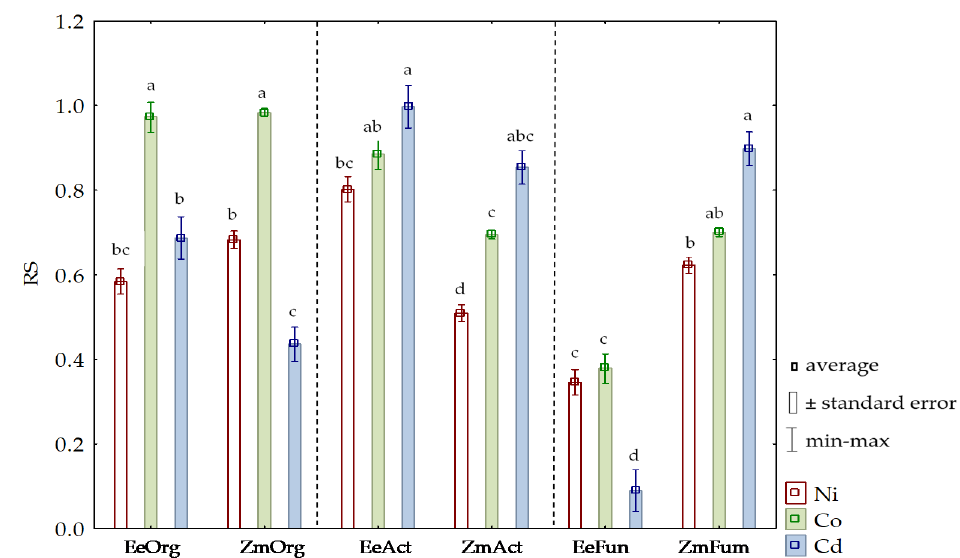
Figure 3. Resistance (RS) of microorganisms to heavy metals in the soil sown with Elymus elongatus L. and Zea mays L. Ee— Elymus elongatus L.; Zm— Zea mays L.; Org—organotrophic bacteria; Act— actinobacteria; Fun—fungi. For each group of microorganisms, the same letters (a–d) are assigned to the same homogeneous groups. The same letters for each group of microorganisms indicate no statistically significant differences.